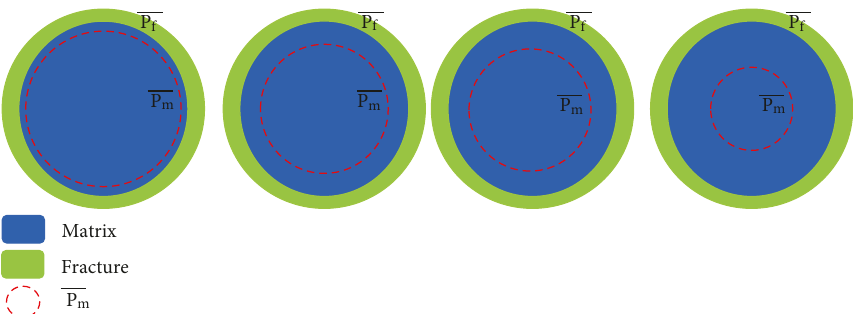
Figure 7: Schematic for the change of average pressure.